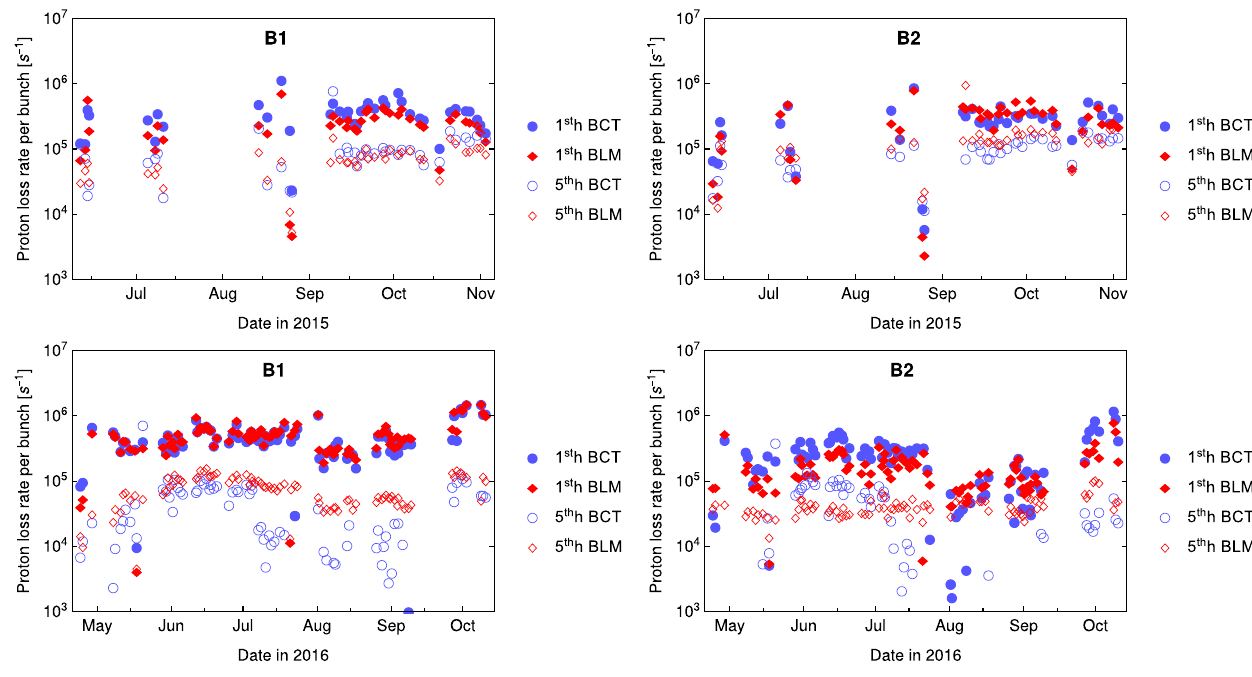
FIG. 6. Average beam loss rates per bunch of B1 and B2 on the TCPs as obtained from the BCT intensity data with the luminosity losses subtracted or from the IR7 BLMs. Results are shown for the two different time periods, the first and the fifth hour, of every physics fill in 2015 (with β (cid:1) ¼ 80 cm) and 2016 (with β (cid:1) ¼ 40